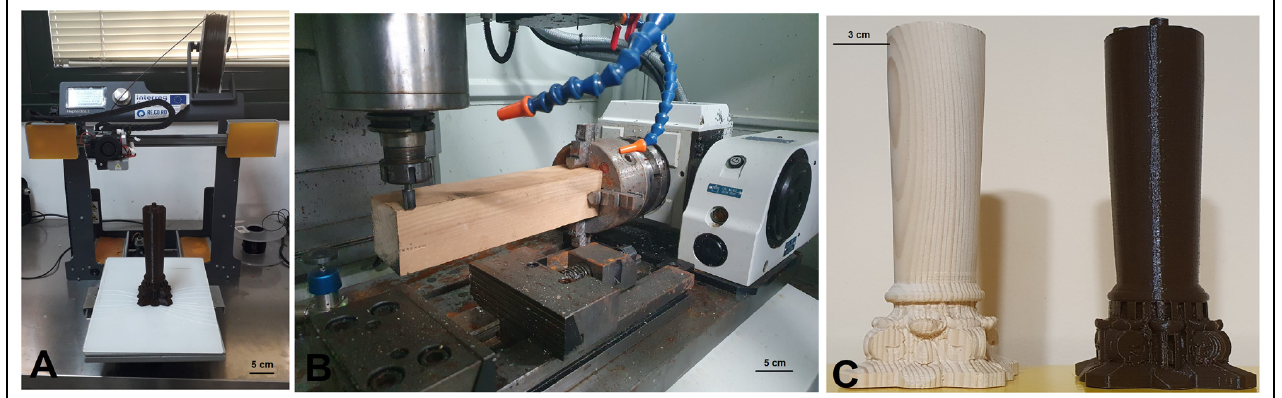
Figure 6. PETG column printing with BQ HEPHESTOS 2 printer ( A ); pine wood column production with HURCO VM 10 ( B ); comparison between the two columns produced ( C ).